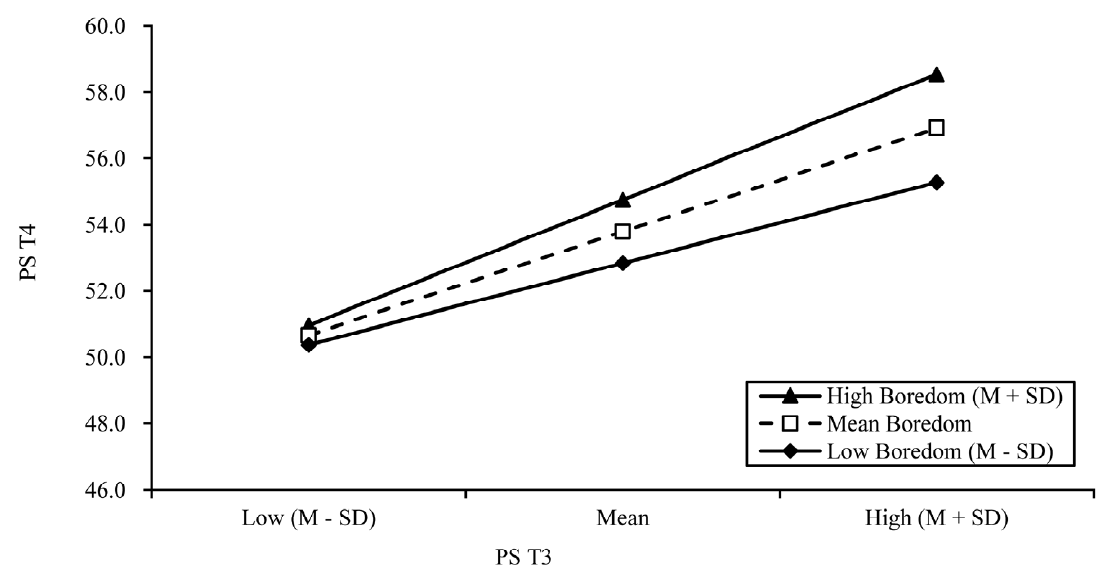
Figure 3. The moderating effect of boredom at T4 on the association between PS at T3 and PS at T4 (N = 197).